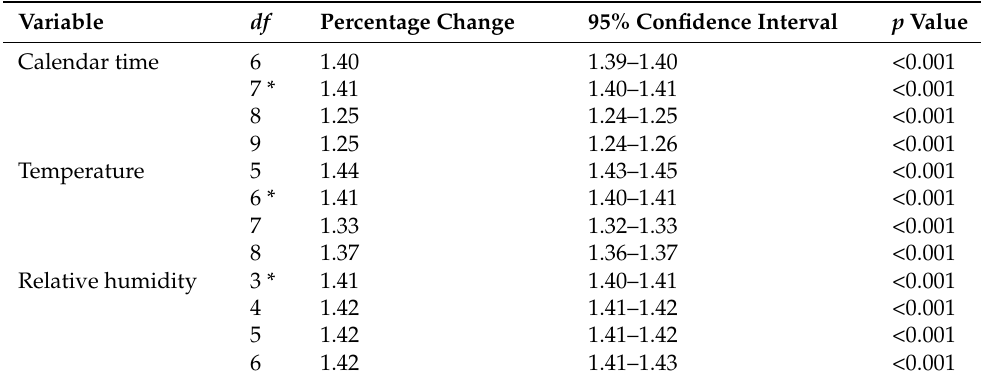
Table 5. Percentage change in the number of outpatient visits for knee osteoarthritis in response to variations in calendar time, temperature, and relative